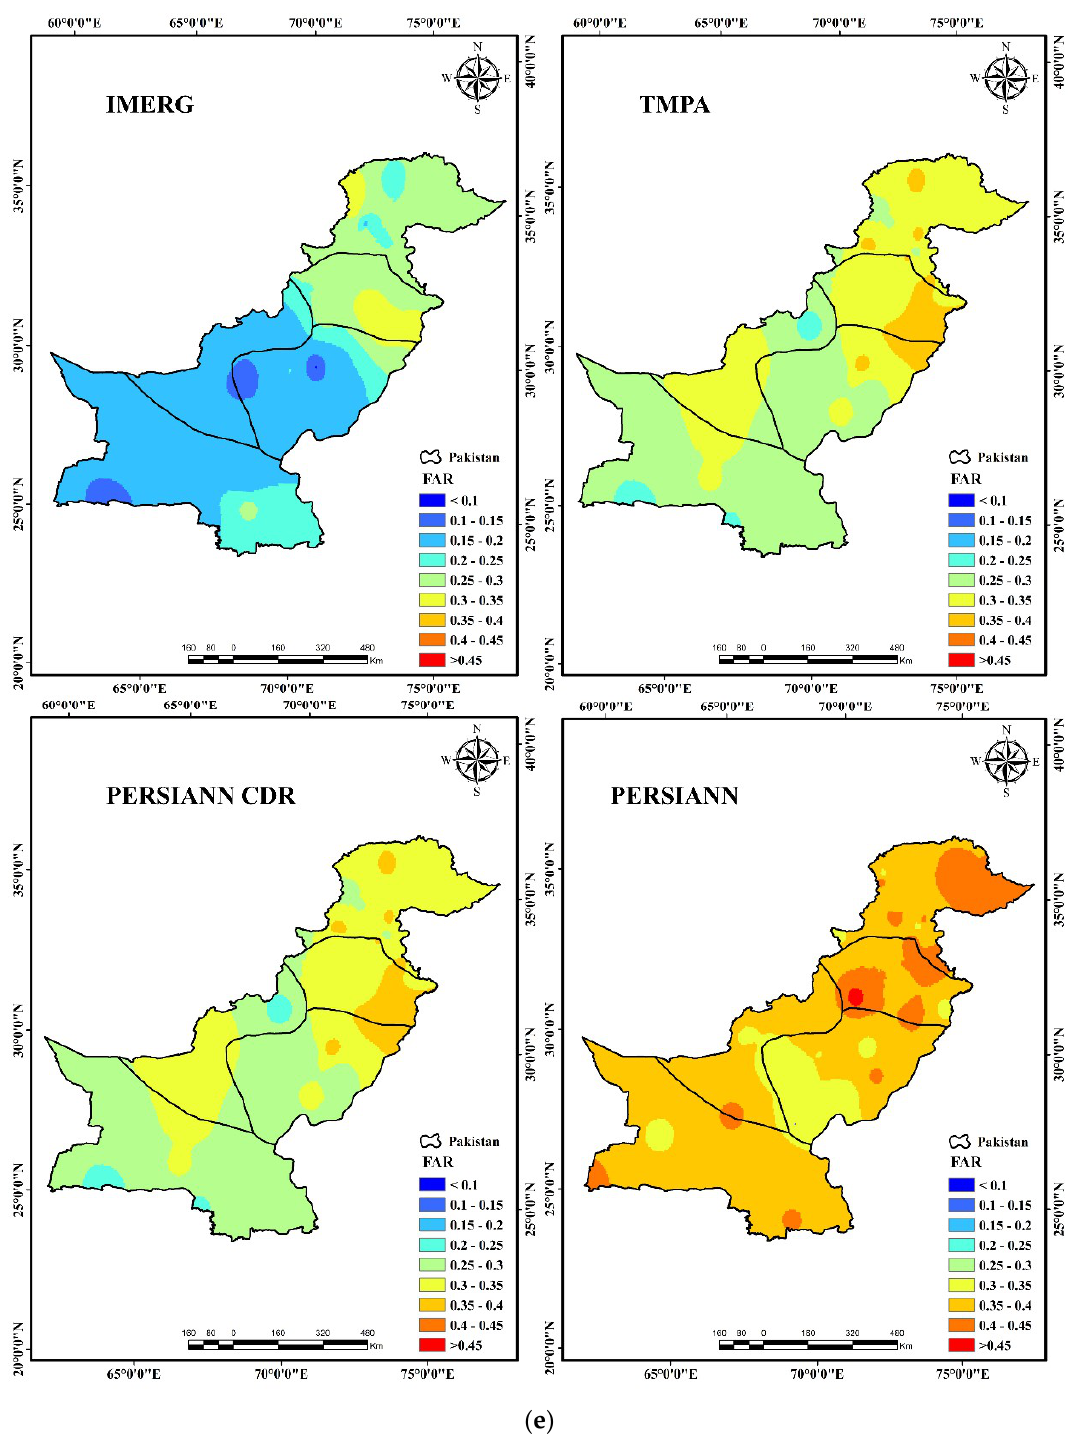
Figure 2. ( a ) Regional distribution of mean error (ME) of satellites precipitation estimates. ( b ) Regional distribution of RMSE of satellite precipitation estimates. ( c ) Regional distribution of CC of satellite precipitation estimates. ( d ) Regional distribution of POD of satellite precipitation estimates. ( e ) Regional distribution of FAR of satellite precipitation estimates.